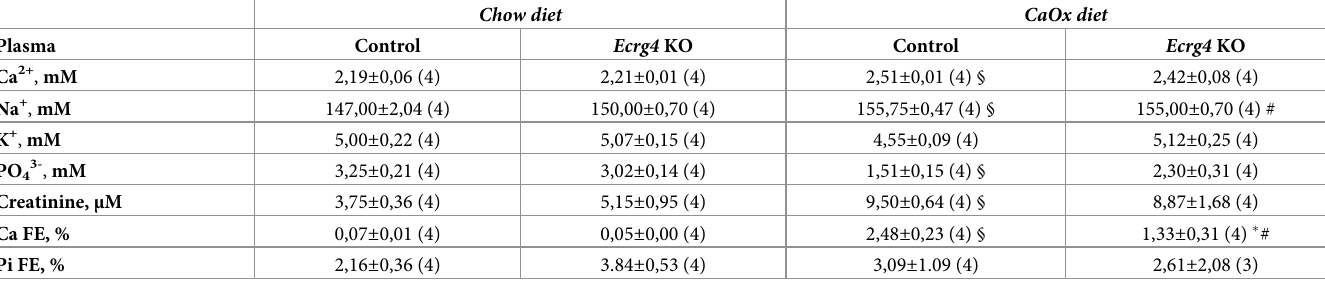
Data are means ± SEM (n). P values are calculated using one-way ANOVA test, with Tukey correction for multiple comparison. � indicates p < 0.05 between control and Ecrg4 KO mice; § indicates p < 0.05 between the two diets for control mice; # indicates p < 0.05 between the two diets for Ecrg4 KO mice.